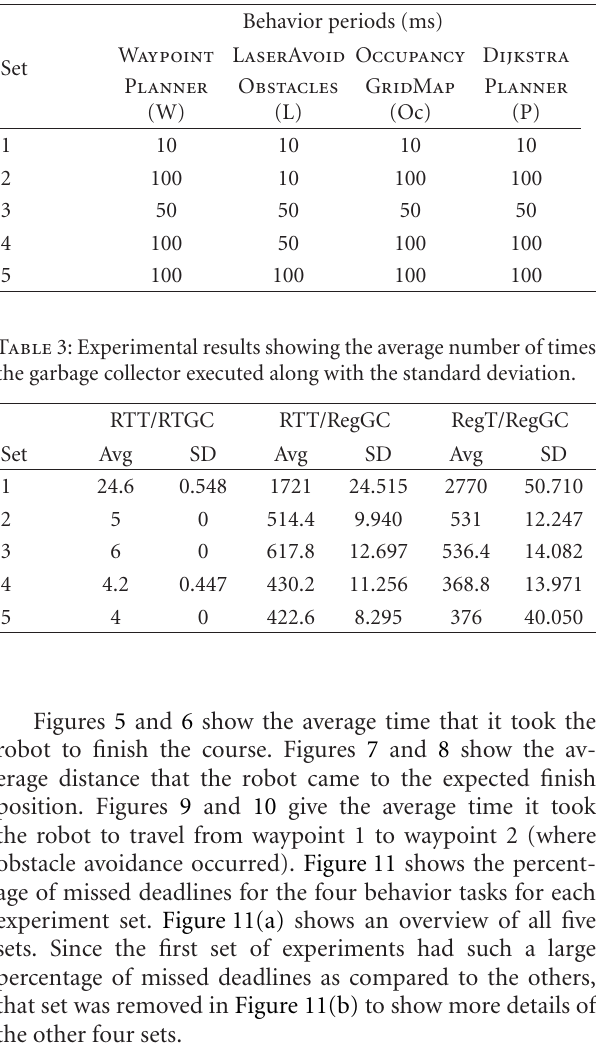
Table 2: Behavior periods for each experiment set.